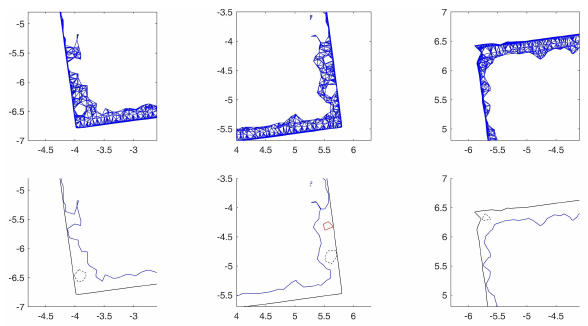
Figure 10: Details of the smaller polygonal chains with relative portions of the Delaunay triangulation.